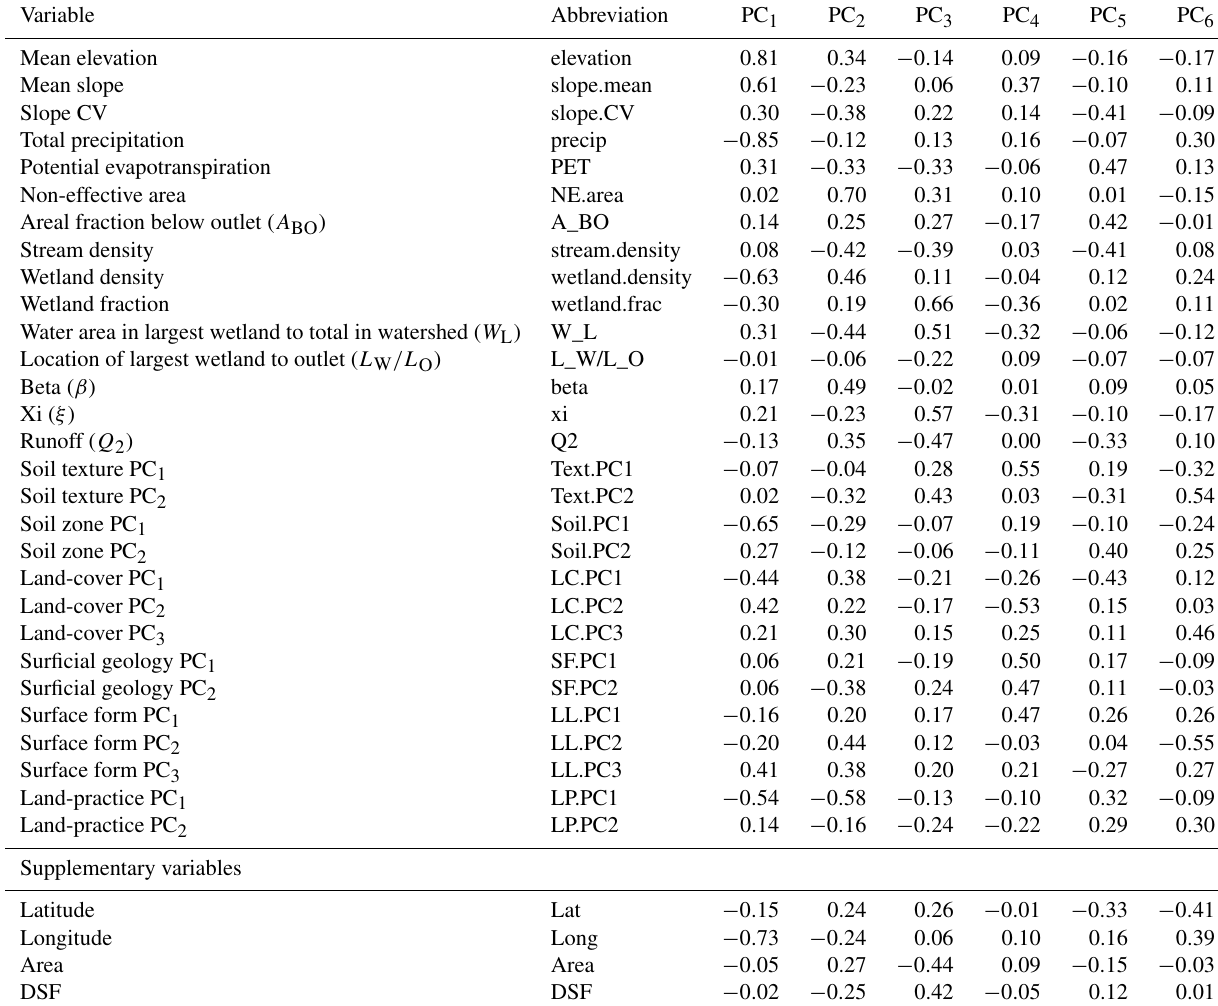
Table 3. Correlation of study watershed attributes with principal components (PCs). The values for the six PCs used in the cluster analysis are